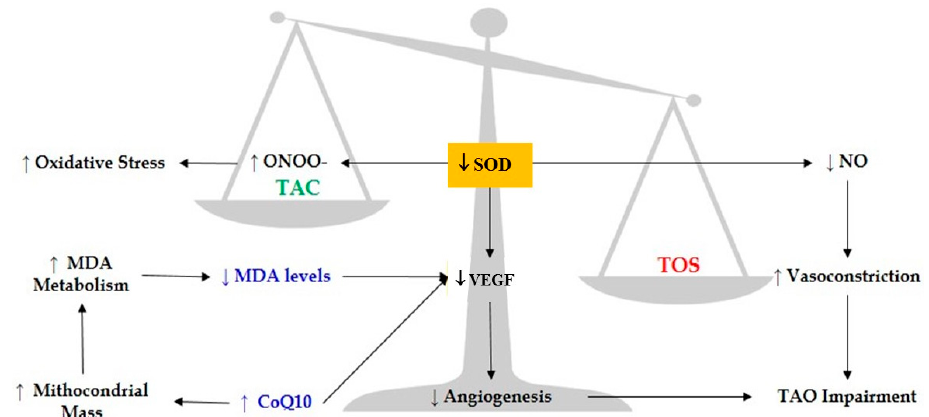
Figure 2. Schematic representation of the imbalance between oxidative stress/antioxidant system and the biomolecular cascade of events in Winiwarter-Buerger patients.